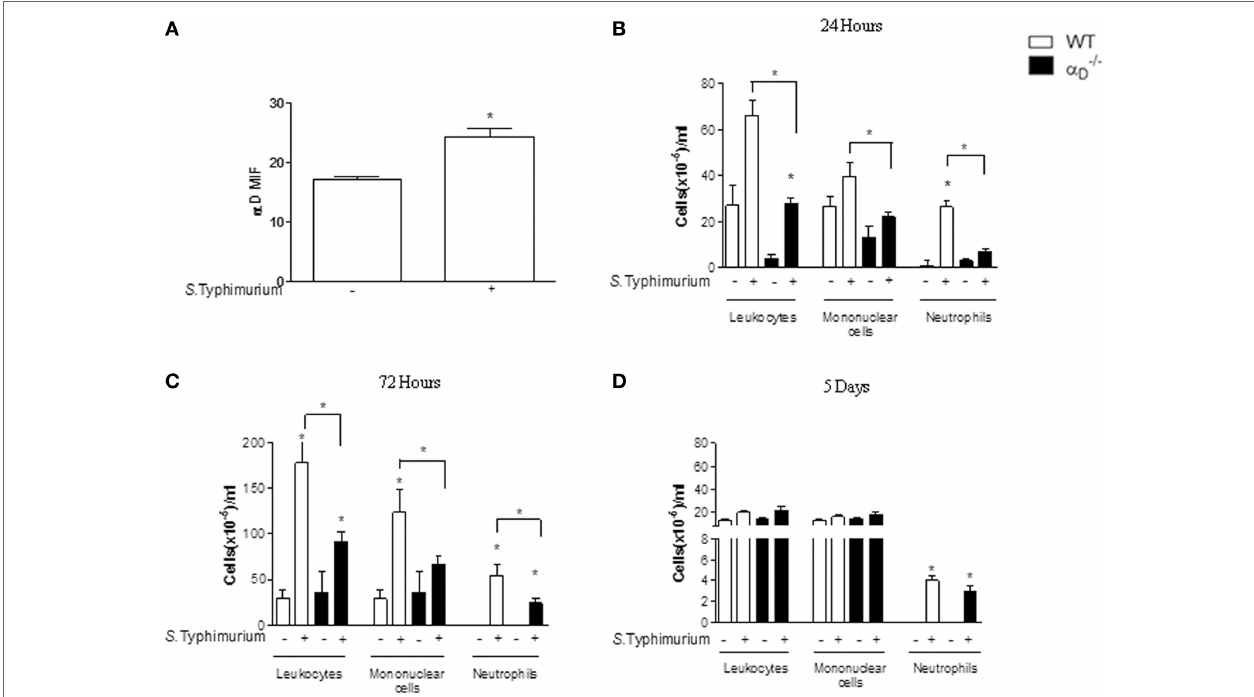
FIGURE 1 | Integrin α D β 2 influences leukocyte accumulation in the peritoneal cavities of mice infected with Salmonella Typhimurium. Wild-type (WT) and α –/– D mice were infected with S. Typhimurium by intraperitoneal injection (10 5 CFU/animal). Control animals were sham-infected by intraperitoneal injection of sterile, apyrogenic saline. (A) After 72h of infection, we collected leukocytes by peritoneal lavage for analysis of α D β 2 expression by flow cytometry [mean fluorescence intensity (MIF)]. In addition, the numbers of total leukocytes, mononuclear cells, and neutrophils in peritoneal fluid samples were determined at (B) 24h, (C) 72h, or (D) 5days after infection. Leukocytes, mononuclear cells, and neutrophils differentiation was performed under an oil immersion objective on cytocentrifuged cells stained with May-Grunwald–Giemsa dye. Each bar indicates the mean (cid:6) SEM from five animals. The figures are representative of the results in four separate experiments. Individual asterisks indicate significant differences ( p < 0.05) between infected and control animals. Bars with asterisks indicate significant differences between α –/– D and WT animals.